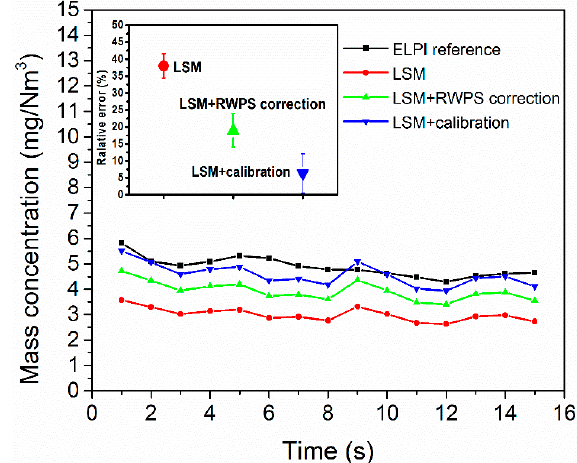
Figure 14. Comparison of real-time mass concentrations measured using the reference method (an electrical low pressure impactor (ELPI)), light scattering method (LSM), light scattering method combined with the ripple width particle size correction (LSM + RWPS) and light scattering calibrated with known particle (LSM + calibration).